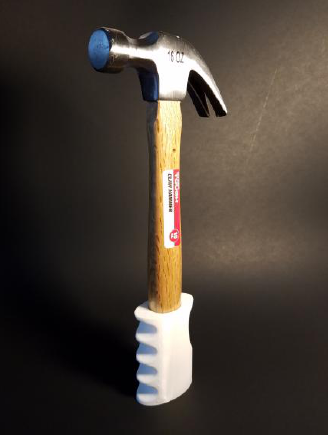
Figure 3. Example of household item, hammer ergonomic grip.